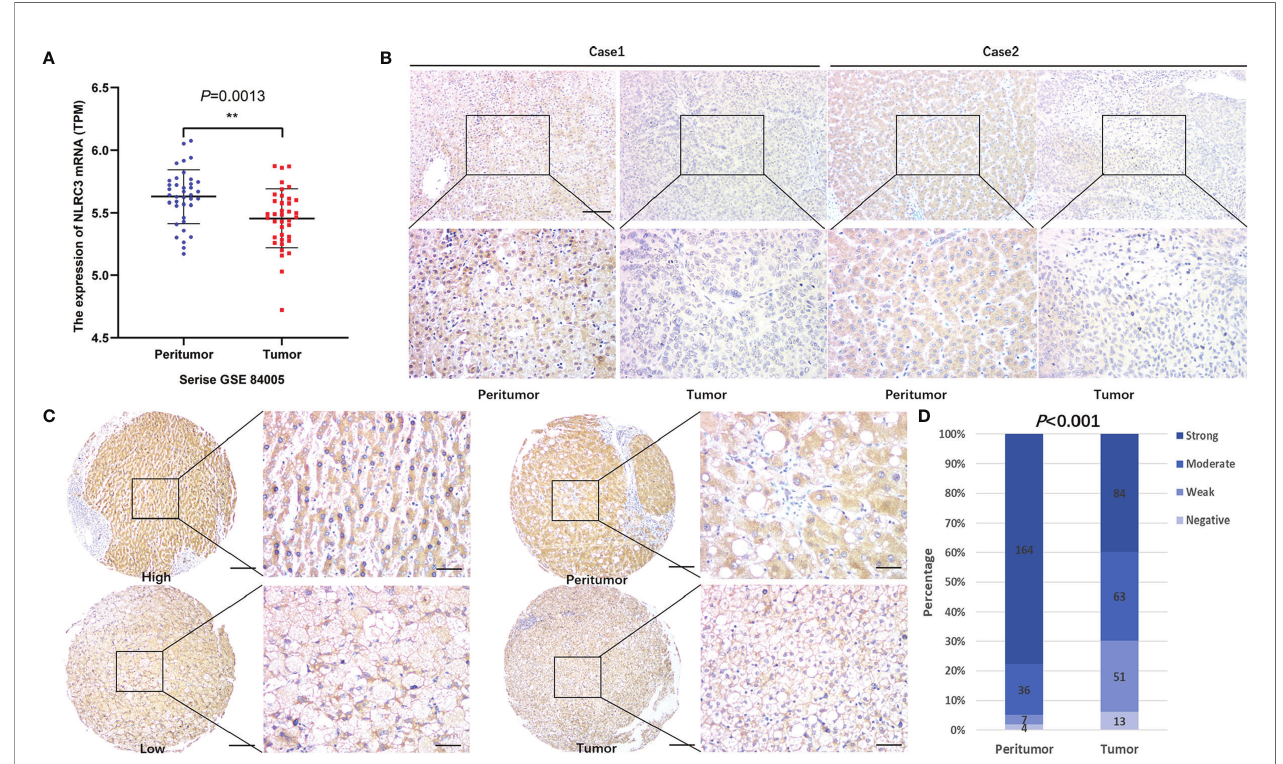
FIGURE 1 | NLRC3 is signi fi cantly reduced in HCC tumor tissues. (A) Marked reduction of NLRC3 mRNA in the HCC group shown by data from the GSE84005 datasets, data was showed as mean expression intensity +SEM. (** P =0.0013). (B) NLRC3 in HCC tissue shown by IHC (magni fi cation 40×, scale bar=500 m m. boxed area 400×, scale bar=50 m m). (C) Representative images of two paired tumor and peritumor tissue samples showing NLRC3 staining (magni fi cation 40×, scale bar=500 m m. boxed area 400×, scale bar=50 m m). (D) 211 paired samples were detected in this study, NLRC3 expression of tumor tissues was signi fi cantly lower than paired peritumor tissue, data was showed as mean expression intensity